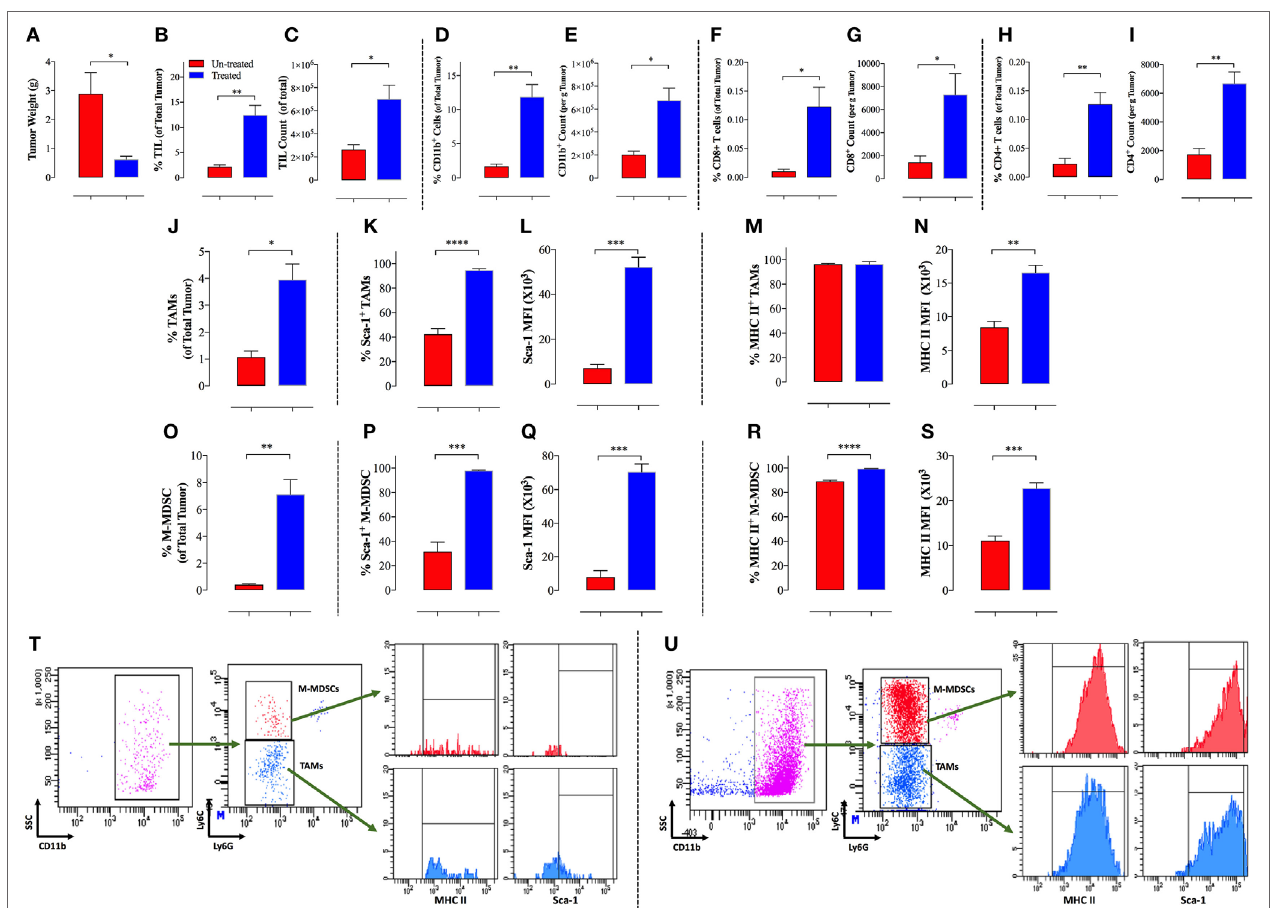
FiGUre 1 | Increased immunogenicity of B16.F1 melanoma tumors following intraperitonial treatment with Salmonella typhimurium strain BRD509E. Decreased tumor weights (A) in Salmonella -treated mice correlates with increased percentage (B) and absolute counts (c) of tumor-infiltrating leukocytes (TIL) as elucidated by CD45 expression and analyzed by multi-color FACS analysis of total tumor cells. Increased cellular infiltration into tumor tissue is observed for CD11b + myeloid cells (D,e) , CD8 + T cells (F,G) , and CD4 + T cells (H,i) . The increase in cellular infiltration is observed in terms of the percentage of indicated cells in the whole tumor (D,F,H) and in terms of absolute cell counts per gram of tumor tissue (e,G,i) . Salmonella treatment also enhanced infiltration and maturation of tumor-associated macrophages (TAMs) (J–N) and monocytic myeloid-derived suppressor cells (MDSCs) (O–s) . Percentage of CD11b + F4/80 + Ly6G − Ly6C − TAMs (J) and CD11b + Ly6G − Ly6C + M-MDSCs (O) among total tumor cells. The proportion of both myeloid cell types was significantly higher in Salmonella -treated tumors than non-treated tumors. Percentage of Sca-1-positive and Sca-1 expression level shown as mean fluorescent intensity among TAMs (K,L) and MDSCs (P,Q) . Percentage of MHC class II-positive and MHC class II expression level among TAMs (M,N) and MDSCs (r,s) . (t–U) Representative FACS plots of the data highlighting the gating strategy for untreated (t) and Salmonella -treated tumors (U) . The gated CD11b + cells are out of selected CD45 + cells. The analysis was carried out on day 12 post Salmonella administration. Asterisks indicate significant differences, * p < 0.05; ** p < 0.01; *** p < 0.001; **** p <